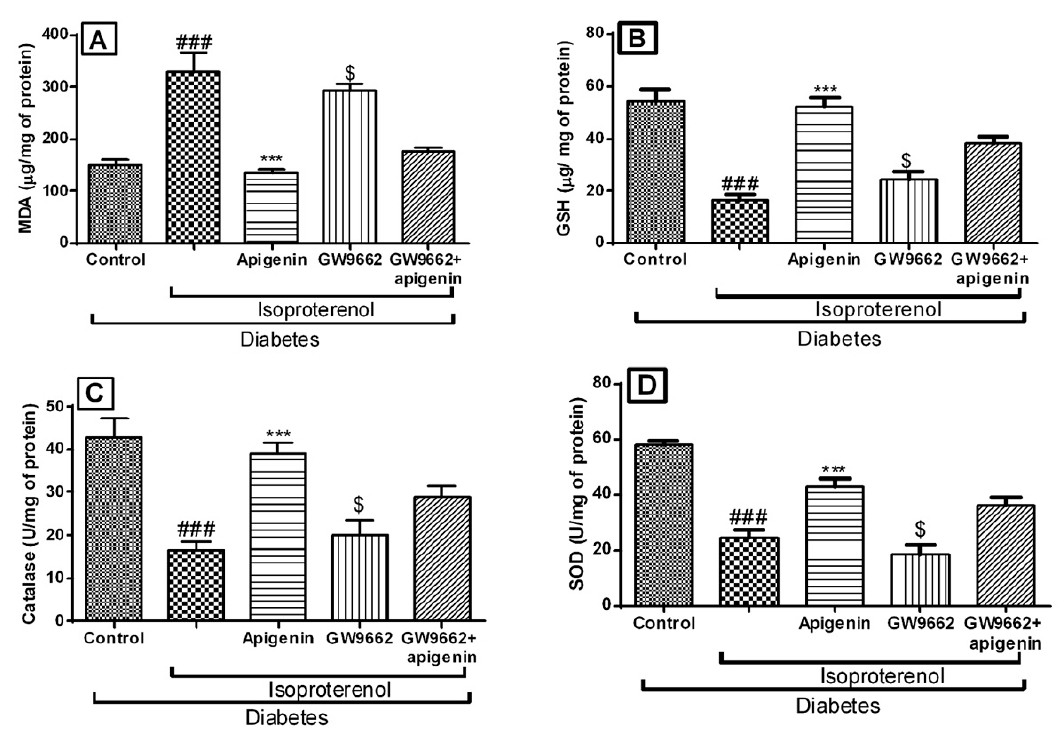
Figure 5. Effects of apigenin on oxidative stress in STZ–isoproterenol treated rats. ( A ) Malondialdehyde (MDA) content; ( B ) Glutathione (GSH); ( C ) Catalase; ( D ) Superoxide dismutase (SOD). The data